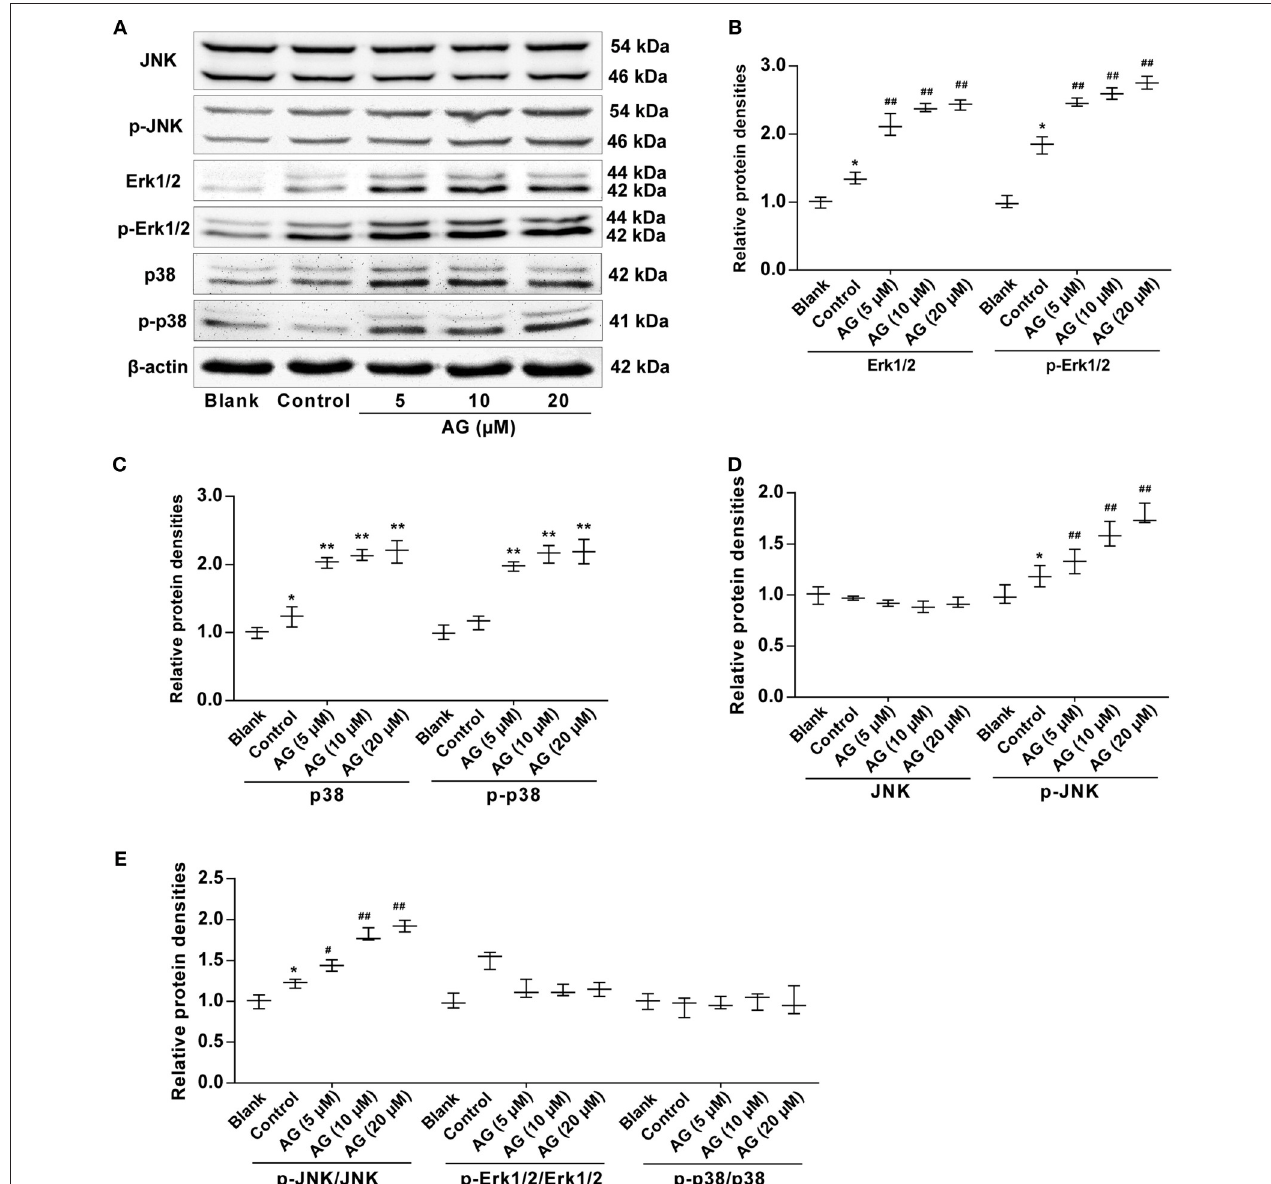
FIGURE 4 | The effects of AG on the protein levels of MAPK signaling molecules in MC3T3-E1 cells. MC3T3-E1 cells were treated with AG at 5, 10, and 20 µ M for 24h. (A) The protein levels of p-Erk1/2, Erk1/2, p-JNK, JNK, p-p38, and p38 were measured by western blot. (B) Quantitative analysis of the protein levels of p-Erk1/2 and Erk1/2 in AG-treated MC3T3-E1 cells. (C) Quantitative analysis of the protein levels of p-p38 and p38 in AG-treated mouse MC3T3-E1 cells. (D) Quantitative analysis of the protein levels of p-JNK and JNK in AG-treated mouse MC3T3-E1 cells. (E) Quantitative analysis of the ratios of the phosphorylated proteins to the total proteins in AG-treated mouse MC3T3-E1 cells. All of the data are shown as the mean ± S.D. of the independent experiments. N = 3. * P < 0.05, ** P < 0.01 compared with the corresponding blank group. # P < 0.05, ## P < 0.01 compared with the corresponding control